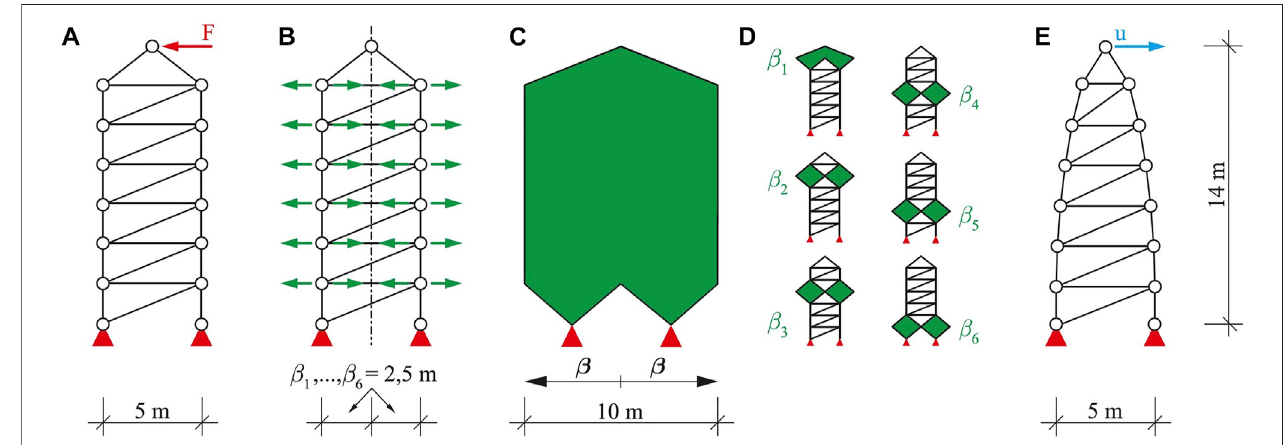
FIGURE 6 | (A) Parametric model of an active truss with jointed connections, loading and support conditions, (B) horizontally variable nodes with symmetrical dependency, (C) design space Ω , (D) isolated parameters β , and (E) result of structural optimization of Γ operator ( Figure 1A ) and ( Table 1 ).